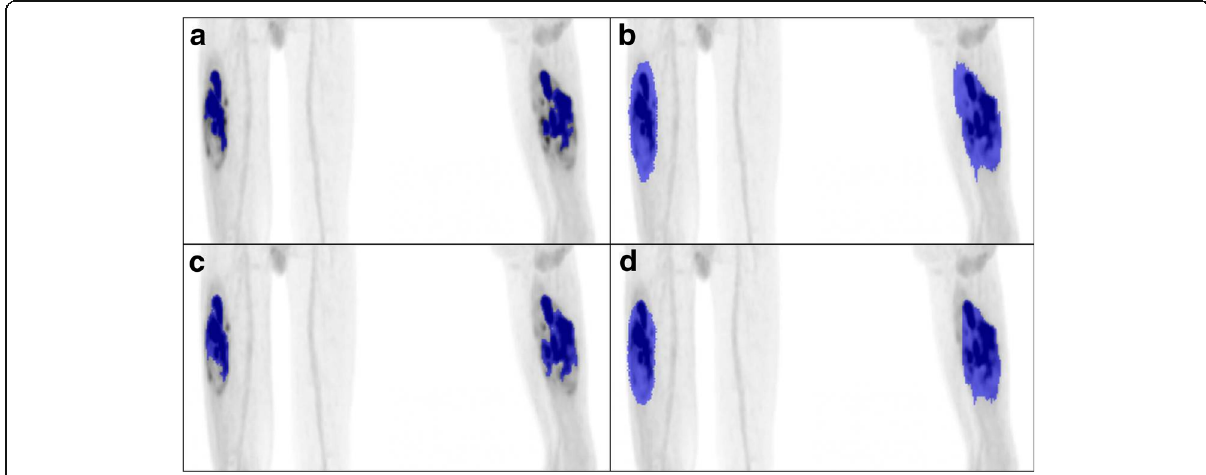
Fig. 2 Differences in tumor delineation between the four VOI delineation techniques. An example illustrating the differences in tumor delineation between the four VOI delineation techniques, for patient 4 scan 2. a VOI auto . b VOI man . c VOI grad . d VOI